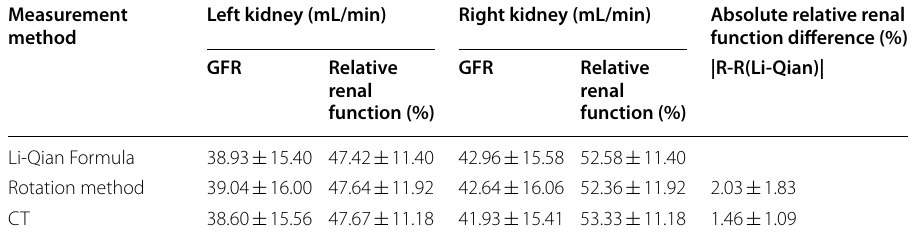
Table 4 GFR and the relative renal function were determined by the three methods Measurement method